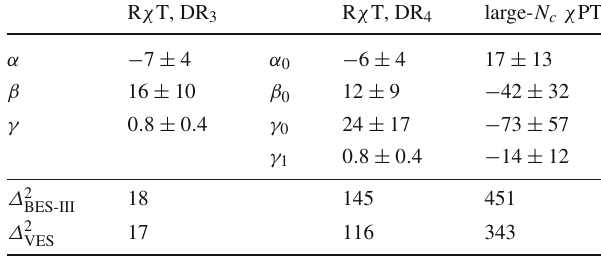
Table 5 Results of the matching between the dispersive amplitude and the large- N c χ PT and R χ T representations. In the case of R χ T, the uncertainties are due to c qq , c d , and c m , while for large- N c χ PT, the errors are due to c qq , c sq , L 2 , L 3 , L 5 , and L 8 . The quantity Δ 2 exp is defined in Eq.